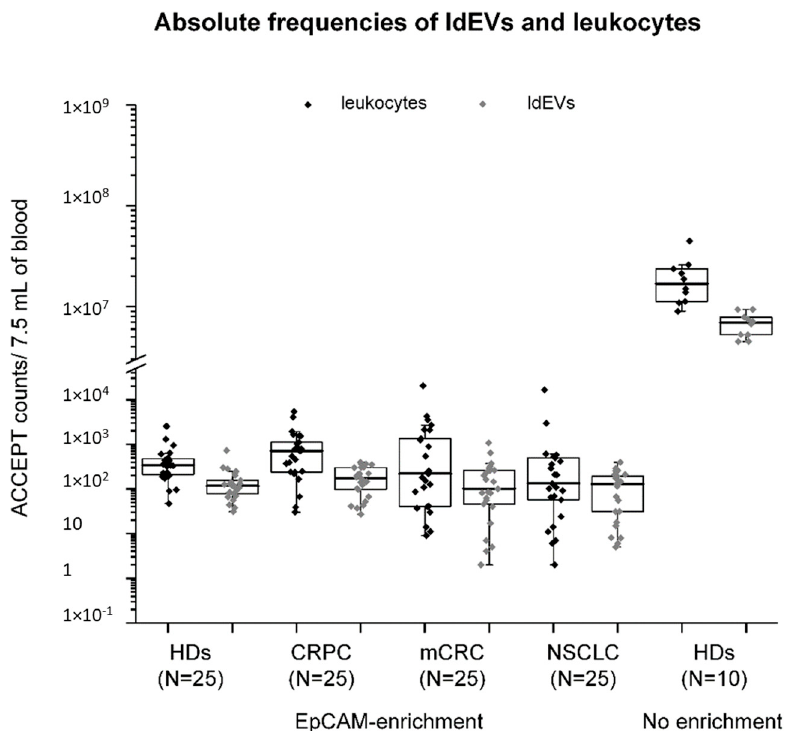
Figure 4. Absolute frequencies of leukocytes and large ldEVs in 7.5 mL of the blood of individuals with and without EpCAM enrichment. The interquartile range of the absolute frequencies of leukocytes (data in black dots) and ldEVs (data in grey dots) in whole blood of 10 healthy individuals and EpCAM enriched blood samples of 25 healthy individuals (HDs) and 75 EpCAM-enriched blood samples of metastatic prostate (CRPC), colorectal (mCRC) and non-small cell lung (NSCLC) cancer patients are shown in box plots. Whiskers indicate max and min values as estimated by Q3 + 1.5*IQR and Q1—1.5*IQR, respectively, where Q1: lower quartile, Q3: upper quartile and IQR: interquartile